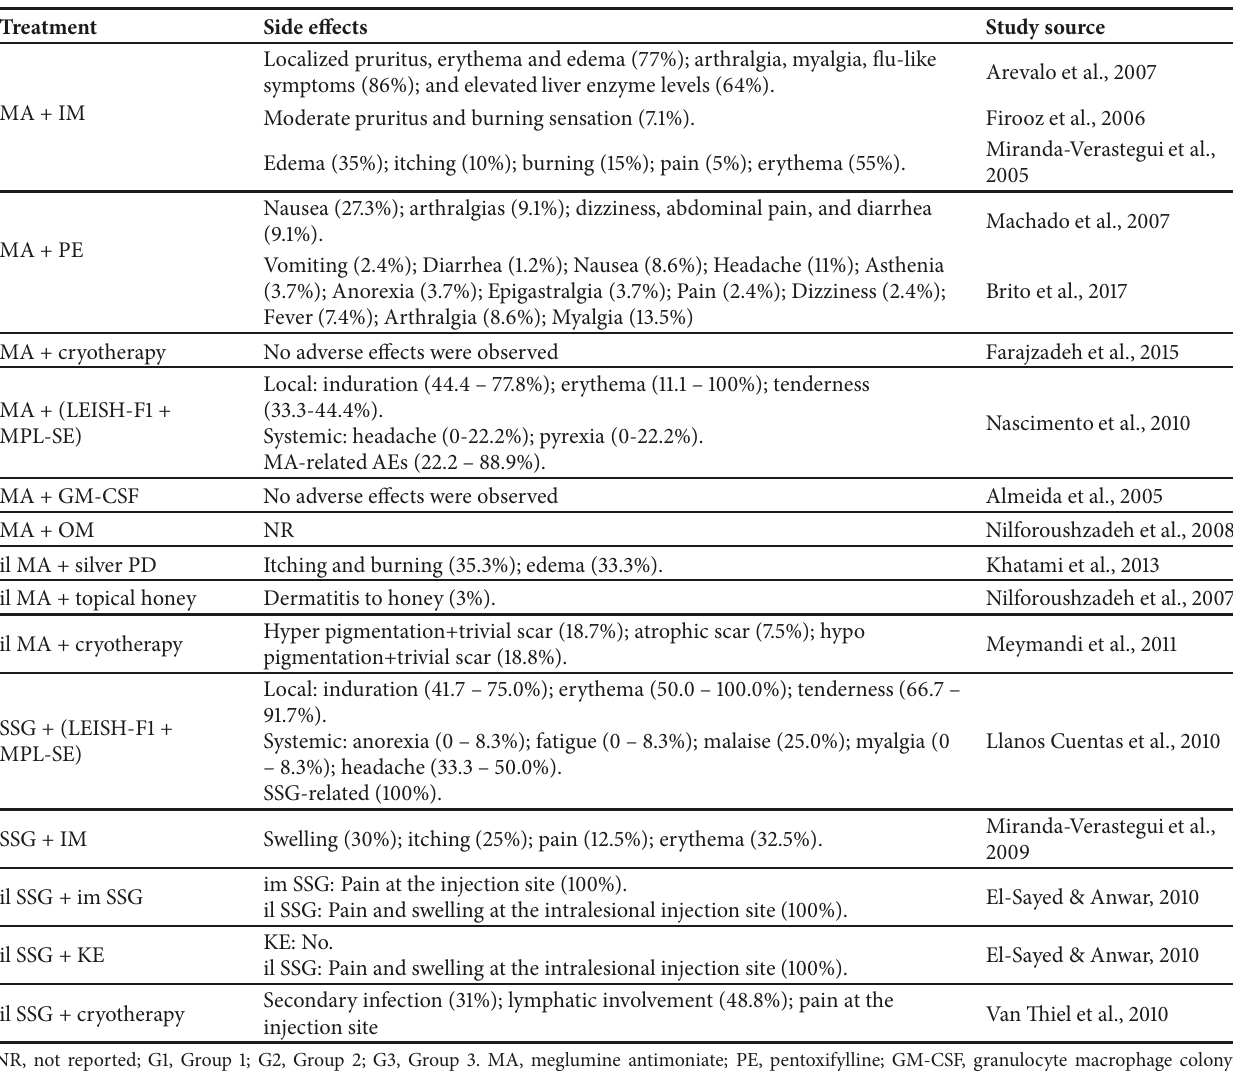
Table 3: Description of adverse effects of combinations for the treatment of tegumentary leishmaniasis.